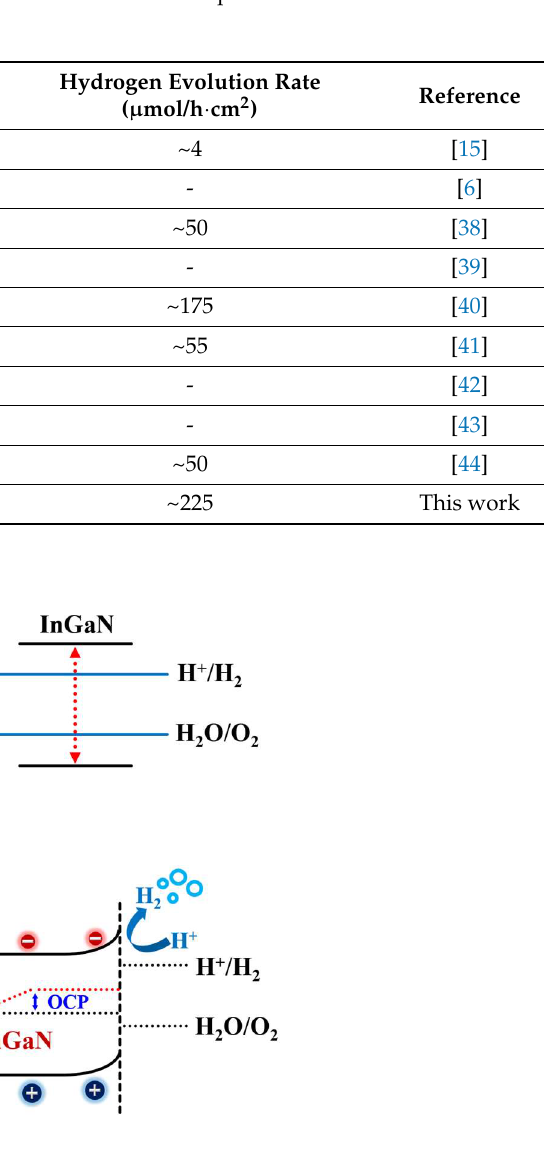
Figure 4. ( a ) Offset parameters with respect to NHE and ( b ) the energy-band structure of an InGaN/GaN HSNW for explaining the spatial behavior of photo-generated carriers at the hetero- interface between InGaN and GaN.